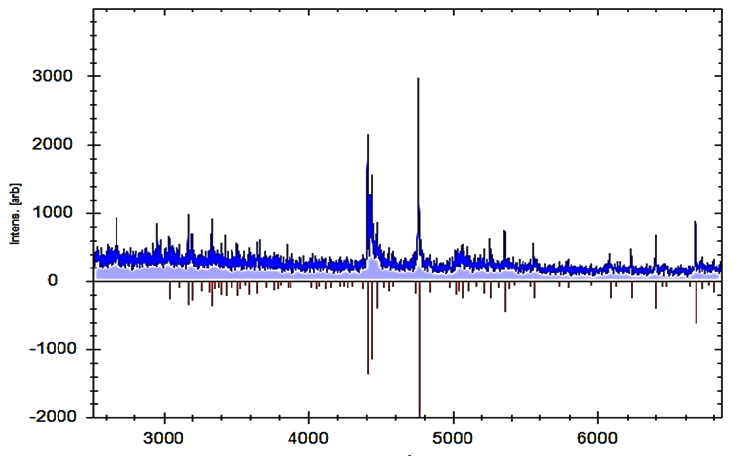
Fig. 3. Comparison of mass spectrum protein profiles of unknown samples (blue) with reference strain E. faecalis 20371 DSM (red)